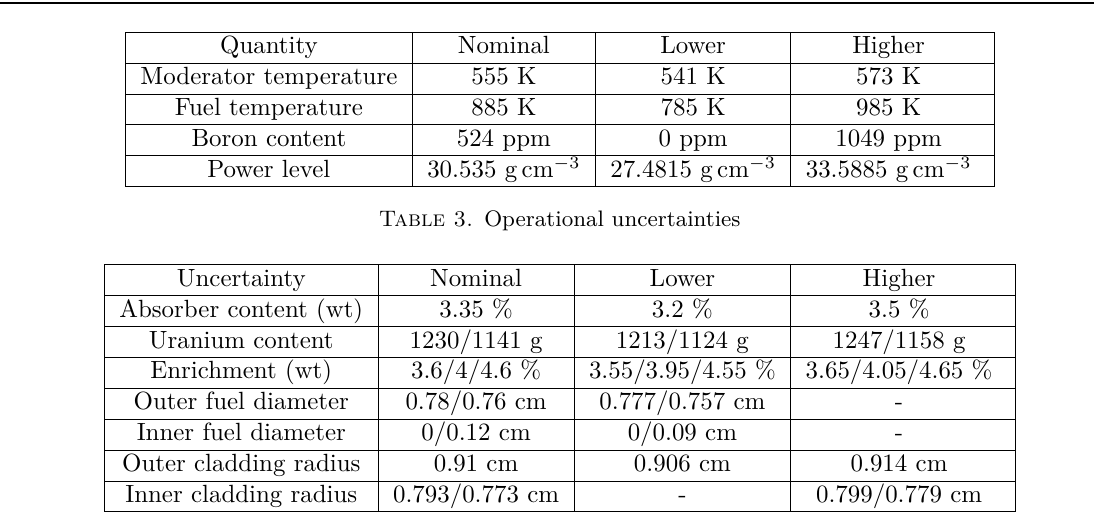
Table 4. Material